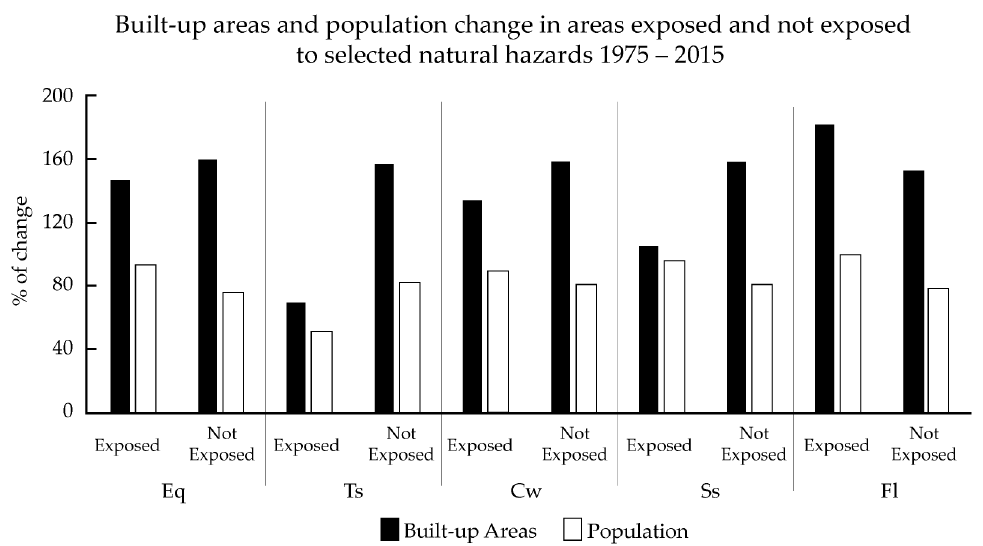
Figure 10. Comparison of relative changes of built-up areas and population respectively exposed and not exposed to the five selected natural hazards between 1975 and 2015. not exposed to the five selected natural hazards between 1975 and